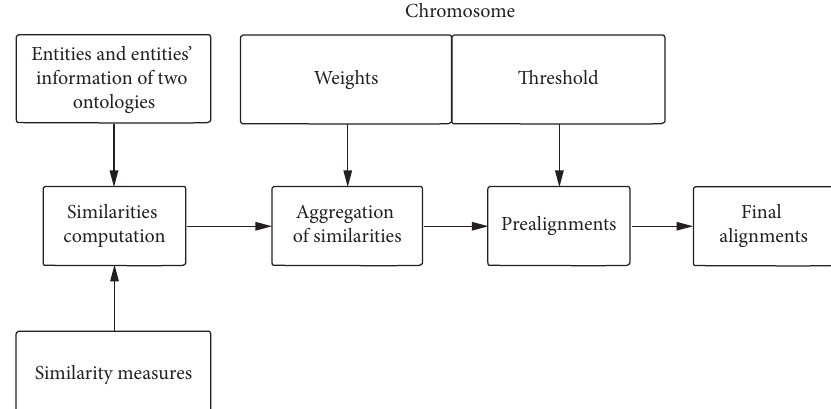
Figure 2: The flow of determining the